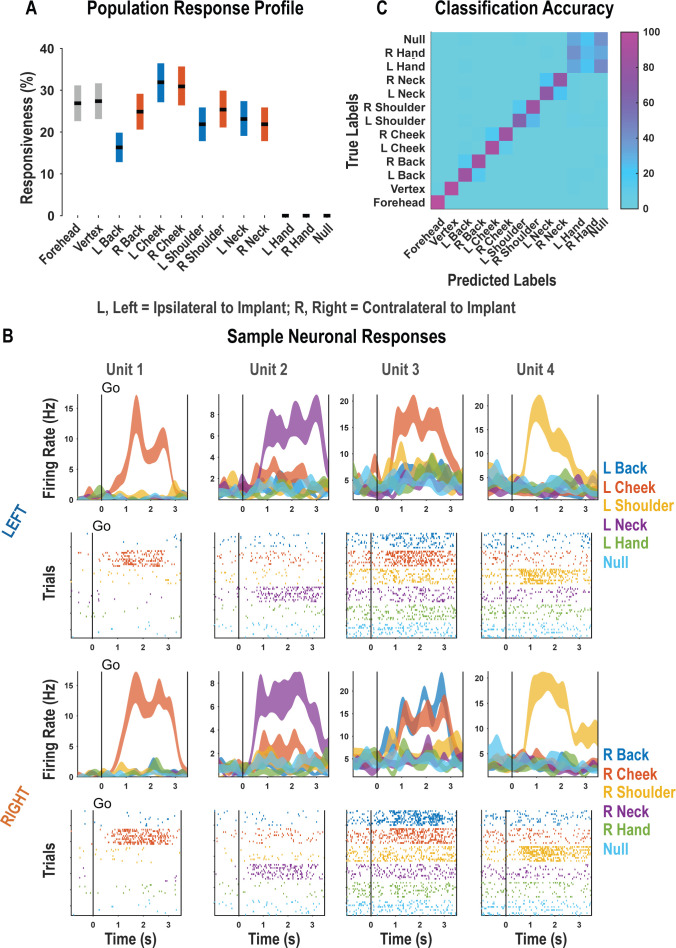
Postcentral-intraparietal (PC-IP) discriminably encodes bilateral tactile receptive fields.(A) Percentage of the PC-IP neuronal population that demonstrated significant modulation relative to baseline for each tested stimulation site (p<0.05, false discovery rate corrected, n = 398 units). Results are shown as the mean percentage (horizontal black line) of the population ± bootstrapped 95% confidence interval (bar height). Gray bars represent truncal (midline) body locations, blue bars represent left (ipsilateral)-sided sites, and orange bars represent right (contralateral)-sided sites. Population results were pooled across recording sessions (Figure 1—figure supplement 1) and were not qualitatively affected by pooling together single and potential multi-units (Figure 1—figure supplement 2). (B) Representative neuronal responses illustrating body part discrimination. Each column of panels depicts the response for one neuron to body parts on the left (top two rows) and on the right (bottom two rows). The first and third rows show the neural response (mean firing rate ± standard error on the mean, n = 10 trials) as a function of time. The second and fourth rows show the spike rasters. Within these rows, each panel depicts the spike activity over each of the 10 trials (rows) and time (x-axis), and are color-coded by tested body site. The vertical line labeled ‘Go’ indicates the start of the stimulus phase. (C) Confusion matrix of the cross-validated classification accuracy (as percentage) for predicting body parts from population neural data. Colors represent the cross-validated accuracy, as in the scale. The matrix is an average of the confusion matrices computed for each recording day individually (Figure 1—figure supplement 3). L: left body, ipsilateral to implant; R: right body, contralateral to implant.